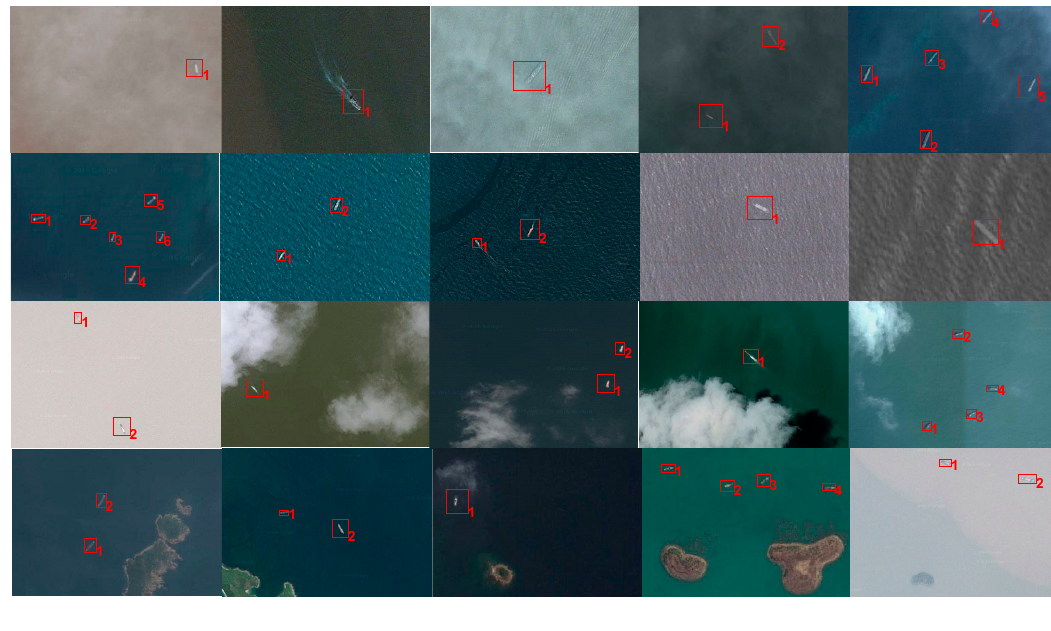
Figure14. Detection results after discrimination. Figure 14. Detection results after discrimination.